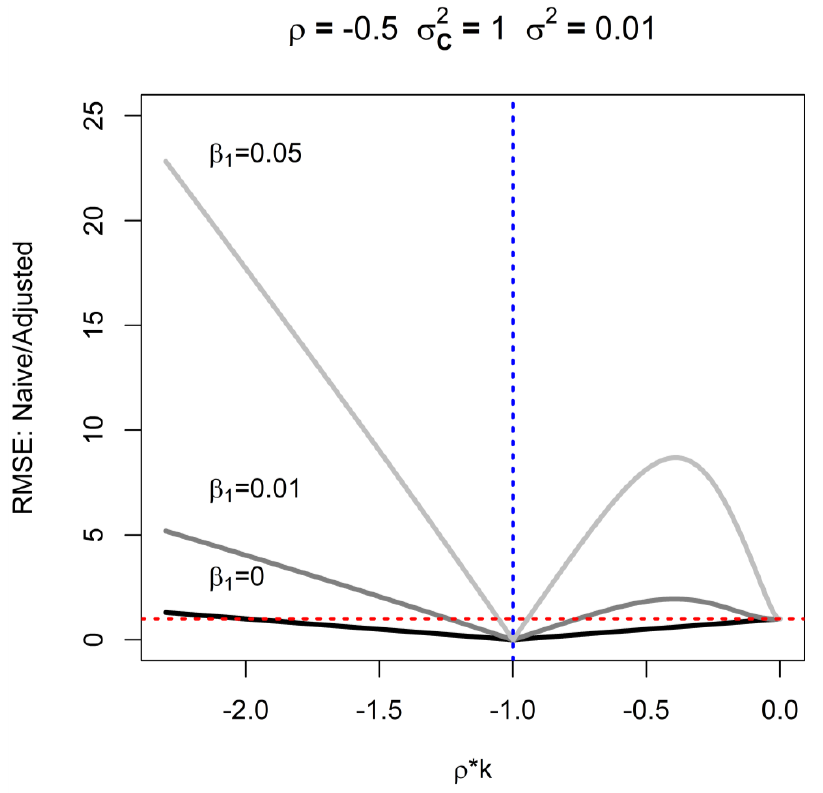
Figure 3. Circumstances when infusion of analysis with additional information on exposure intensity is expected to degrade root mean squared error (RMSE), as a function of correlation of intensity and duration (ρ = −0.5), ratio of variances of intensity and duration (k), and strength of causal effect (β 1 ) for n = 5000, σ 2 = 0.01, Var (log C) = 1; red line indicates where RMSE’s are equal; blue line indicates where adjusted RMSE is undefined.